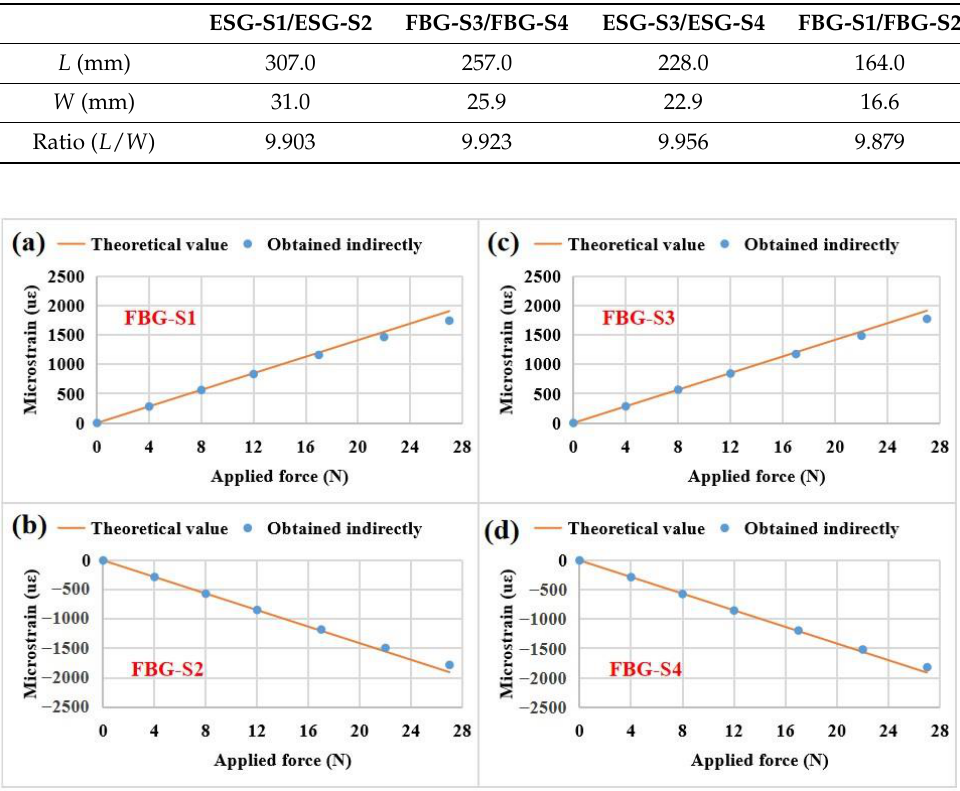
Figure 9. Comparisons of the theoretical and practical microstrains of the four FBG strain sensors mounted on the cantilever beam as a function of the applied forces from 0 N to 27 N: ( a ) FBG-S1, ( b ) FBG-S2, ( c ) FBG-S3, ( d ) FBG-S4.